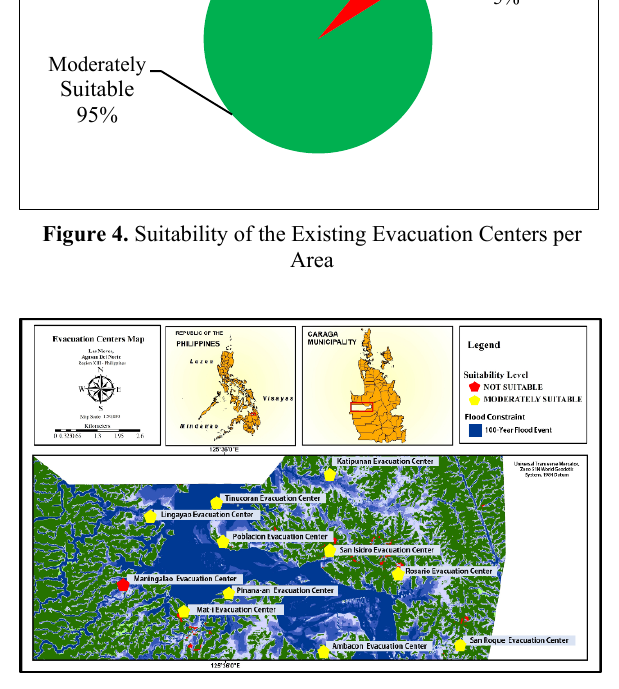
Figure 5. Existing Evacuation Centers Level of